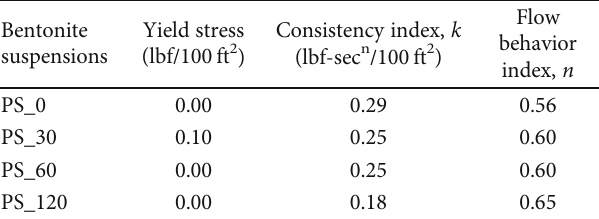
Figure 3: Shear rate vs. shear stress for experimental data and HB Table 2: Rheology of aged bentonite suspensions.